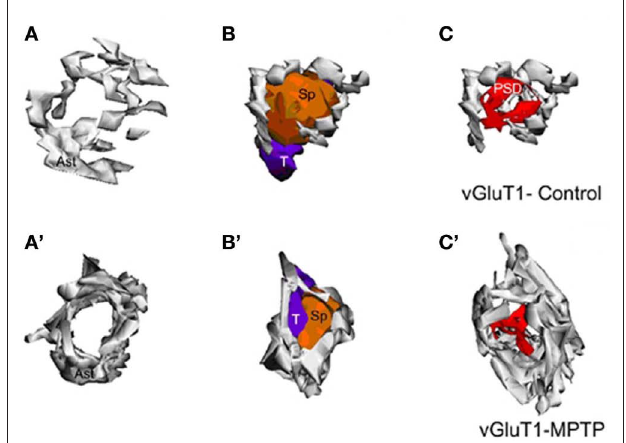
Figure 3 | electron micrographs of a vgluT1-immunoreactive tripartite synapse (TS) in the striatum of a control (A) and a MPTP-treated (B) monkey. Perisynaptic astrocytic processes (Ast) are pseudocolored in blue in (A,B) . These single EM images highlight differences in the extension of the astrocyte wrapping of an axo-spinous synapse between control (A) and MPTP (B) treated animals. Pictures were digitally acquired and imported in TIFF format to Adobe Photoshop (version 7.0; Adobe System, San Jose, CA, USA). Abbreviations: Ast, astrocyte; T, axon terminal; Sp, dendritic spine. Scale bar in (B) [valid for (A) ]: 1 μm.